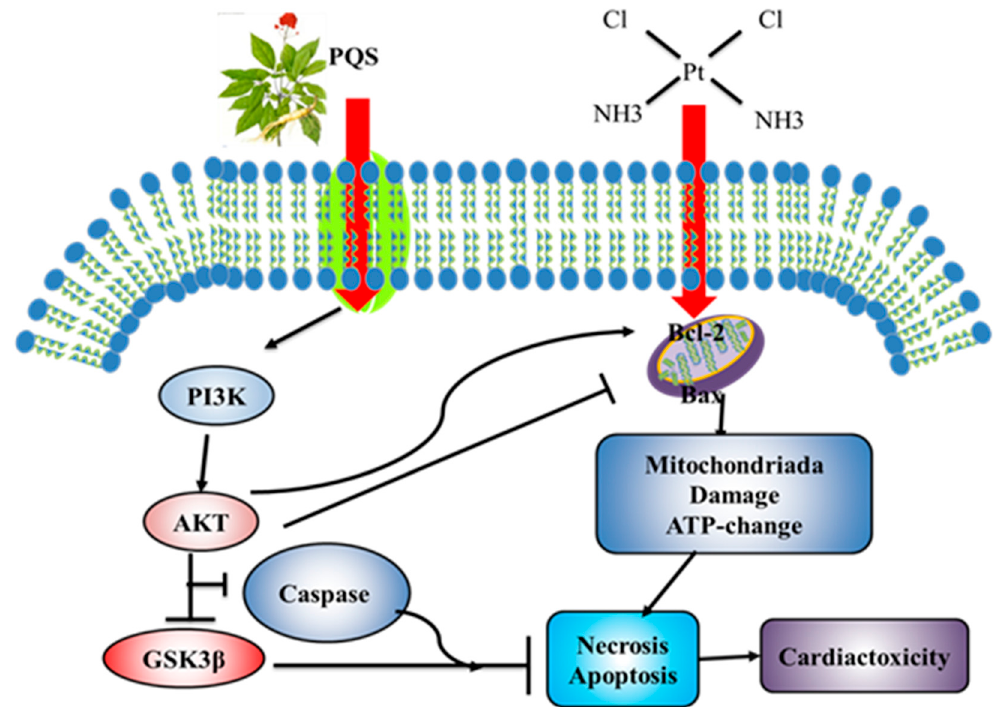
Figure 9. Scheme Summarizing the Inhibition of Cisplatin-Induced Cardiotoxicity by PQS via the Upregulation of PI3K/Akt/GSK-3 β Mediated Inhibition of Oxidative Stress Inflammation and Apoptosis.